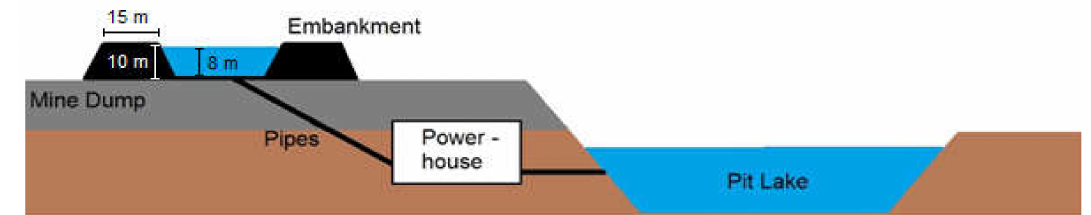
Figure 2. Technical concept of a semi-underground pumped hydro storage plant